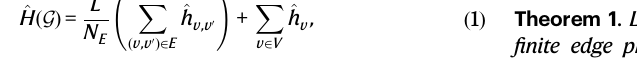
not to betrue, the graph must possess a non-trivial cut and weprove thateven